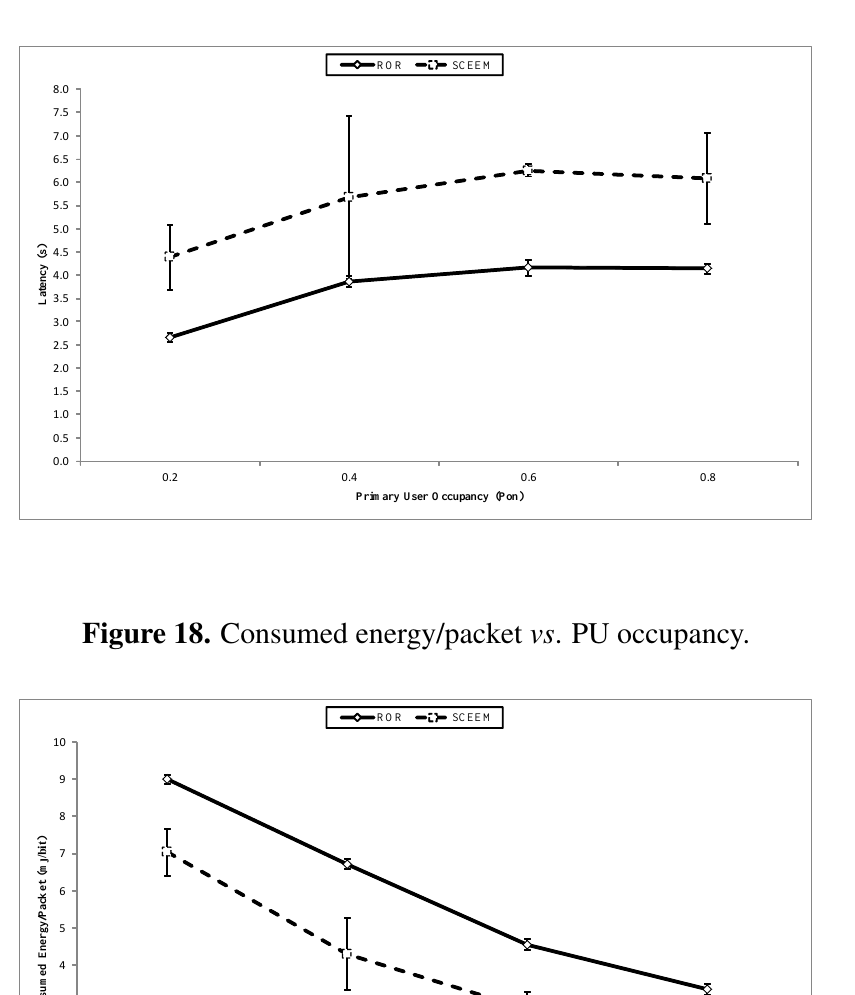
Figure 17. Latency vs . PU occupancy.